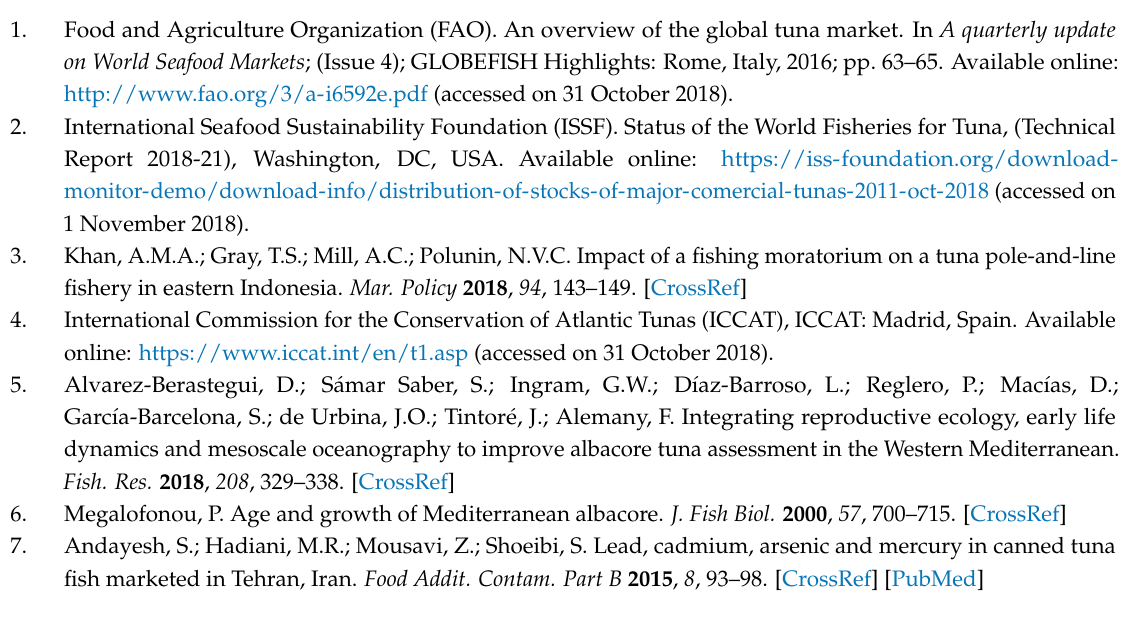
Table S1: Biological data of NASSA and SASSA T. alalunga samples. Table S2: Concentrations (mg kg − 1 wet wt) of selected heavy metals of NASSA and SASSA T. alalunga samples, Table S3: Spearman Rank Order Correlations between parameters of NASSA samples, Table S4: Spearman Rank Order Correlations between parameters of SASSA